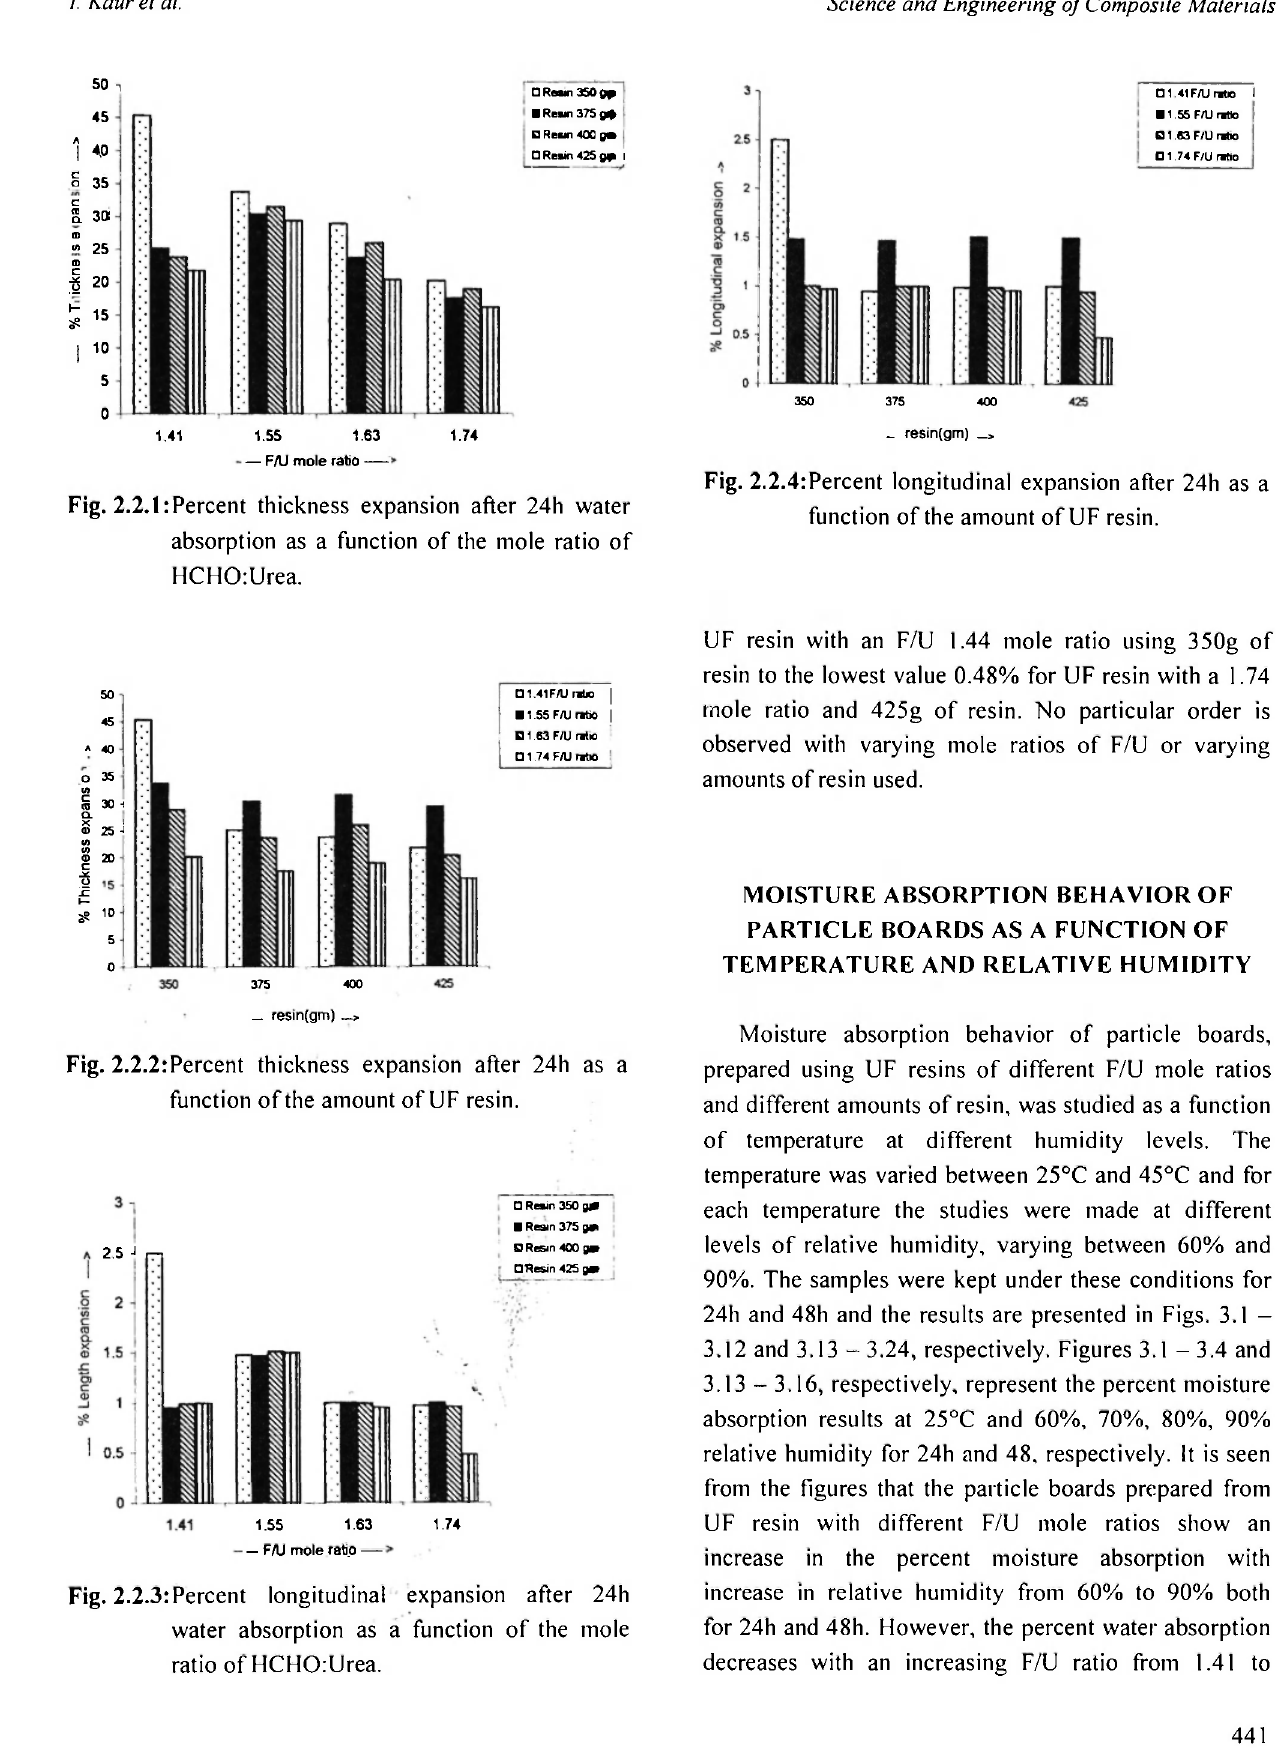
Fig. 2.2.3: Percent longitudinal expansion after 24h water absorption as a function of the mole ratio of HCHO:Urea.